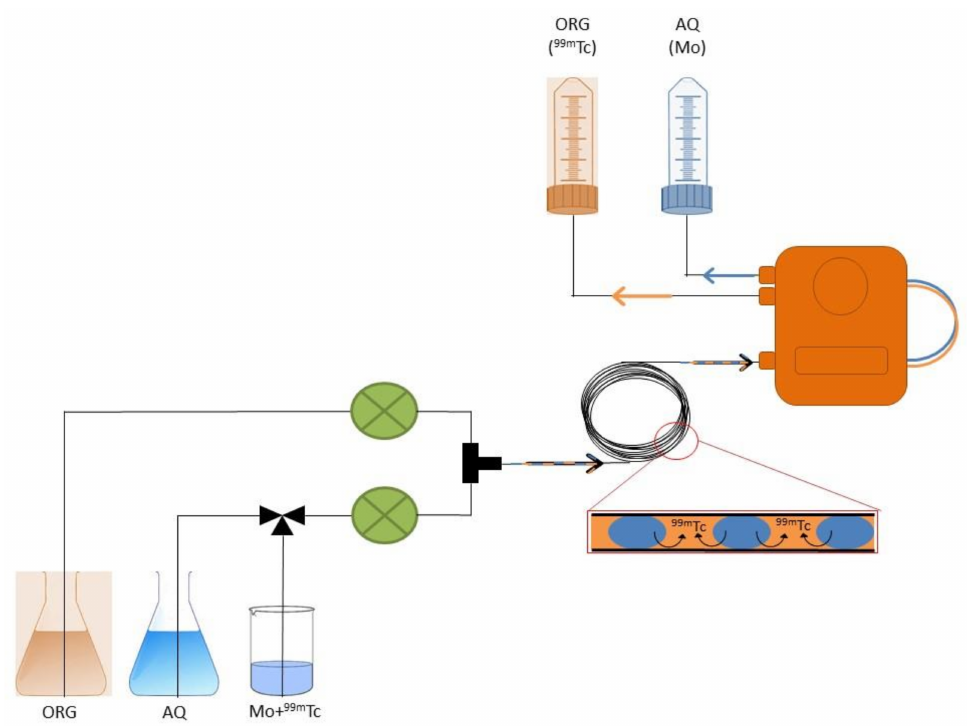
Figure 2. Diagram of the extraction and separation system.